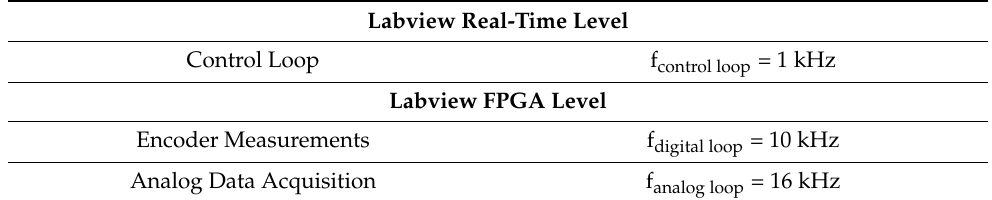
Table A2. Table A2. Loop rates of main processes.